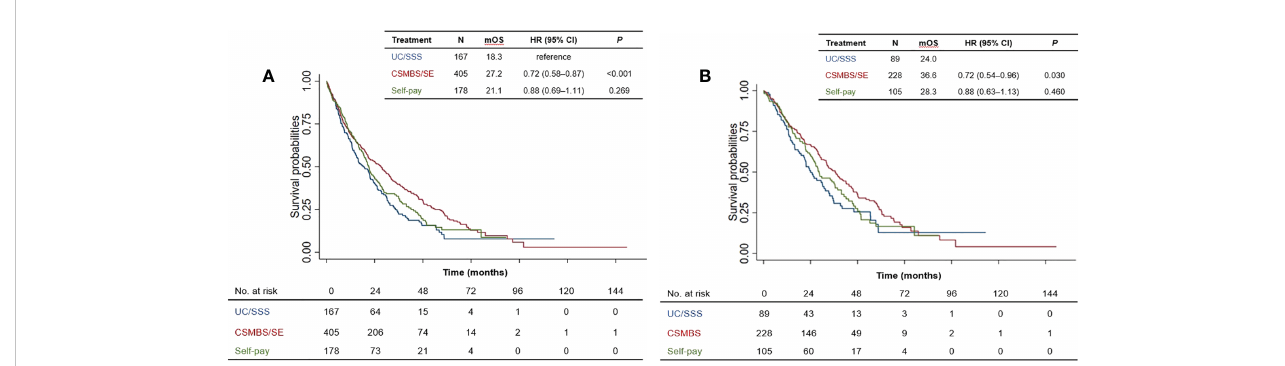
FIGURE 3 Overall survival of patients according to healthcare coverage scheme for (A) total patient population, and (B) EGFR m-positive patients. mOS, median overall survival; HR, hazard ratio; CI, con fi dence interval. UC, Universal Coverage; SSS, Social Security Scheme; CSMBS, Civil Servant Medical Bene fi t Scheme; SE, State Enterprise